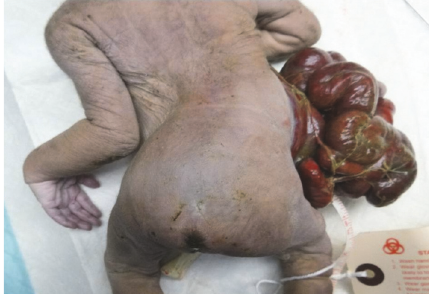
Figure 3: Figure shows kyphoscoliosis of the thoracolumbosacral spines and sacral dimples.